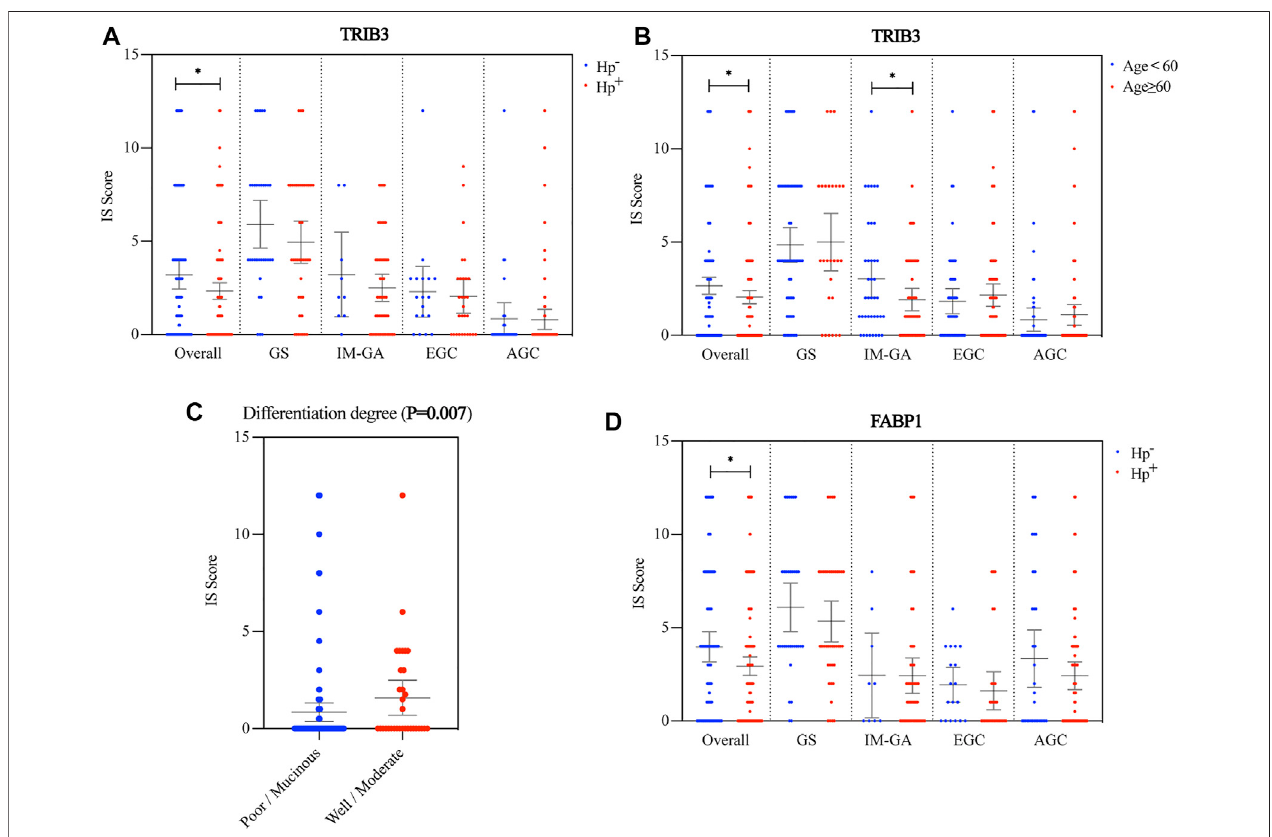
FIGURE 2 | Association between the protein expressions of TRIB3 and FABP1 and clinicopathological parameters. TRIB3 was correlated with Hp infection status (A) and age (B) . Besides, it was signi fi cantly correlated with the differentiation degree in AGC (C) . FABP1 was also correlated with Hp infection status (D) .